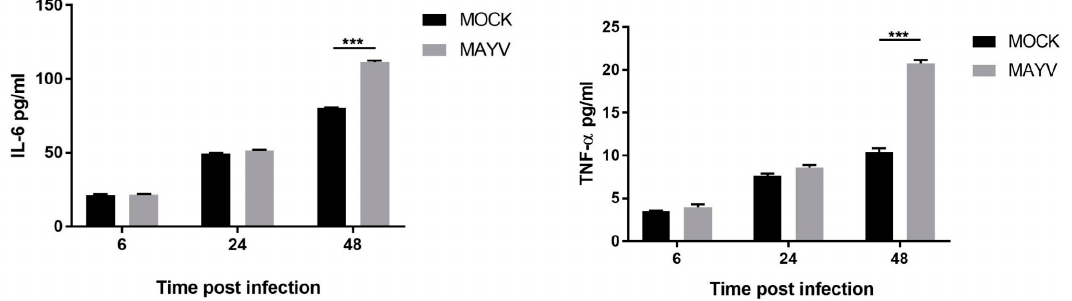
Figure 4. MAYV increases the production of proinflammatory cytokines in primary human chondrocytes. IL-6 and TNF- α secretion were quantified in the supernatant of infected cells using ELISA. Mock-infected cells were used as control. The data represent three independent experiments, each performed in triplicate. The two-way ANOVA statistical analysis with Bonferroni’s test was used to analyse the set of data. *** p < 0.0001.